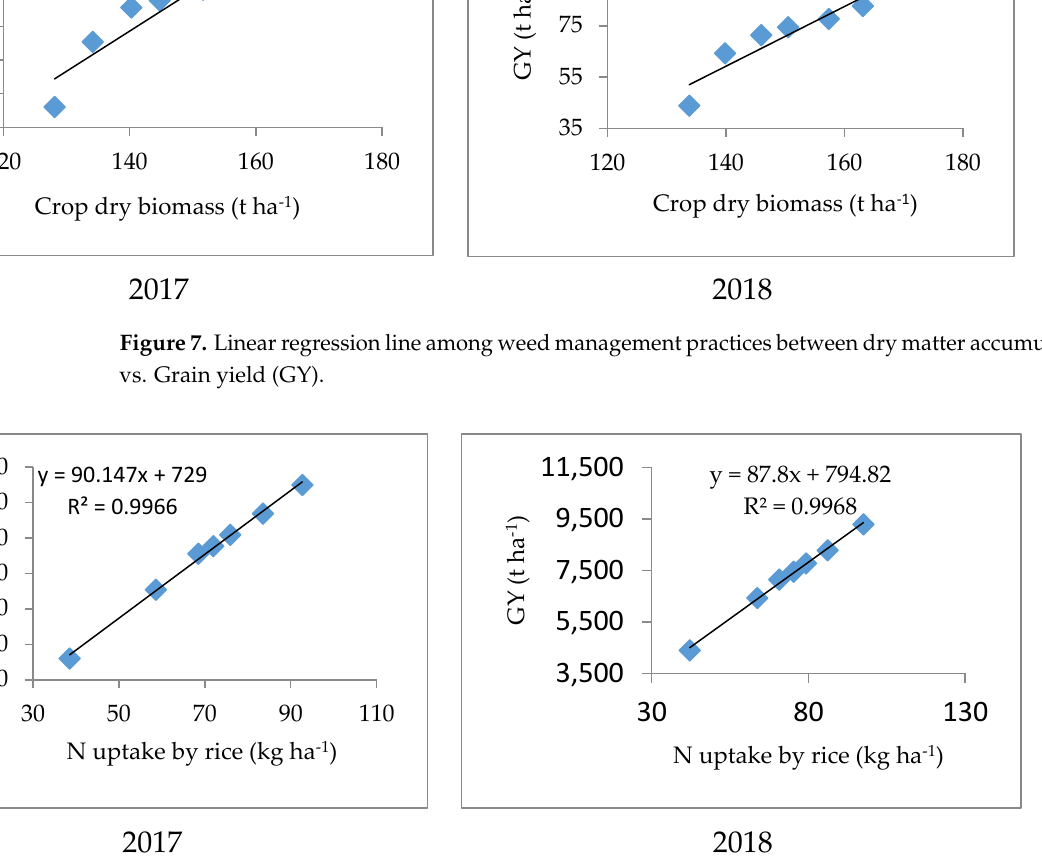
Figure 8. Linear regression line among weed management practices between N uptake vs. Grain yield (GY).